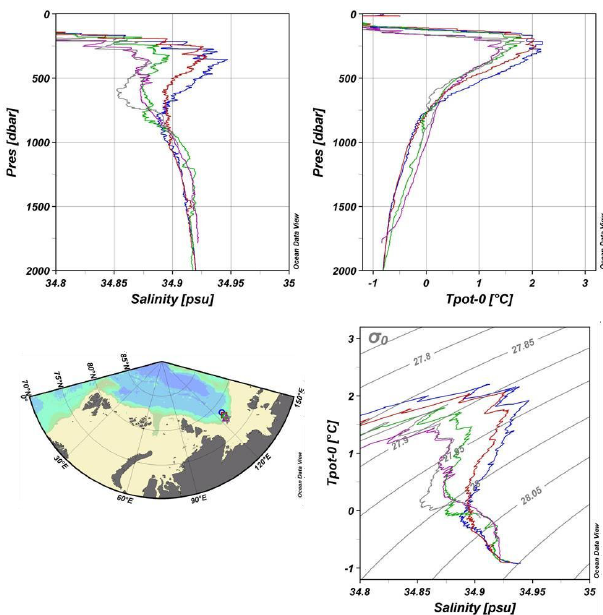
Fig. 10 . Profiles of salinity and potential temperature, and θS curves from the Laptev Sea slope. No smooth temperature and salin- ity profiles are seen in the Fram Strait branch Atlantic core, and the presence of intrusive layers indicates mixing between the branches. The Atlantic water is still warmer and more saline over the deeper part of the slope (red and blue stations) than closer to the shelf but has become considerably colder and less saline compared with sec- tion 3 (Fig.